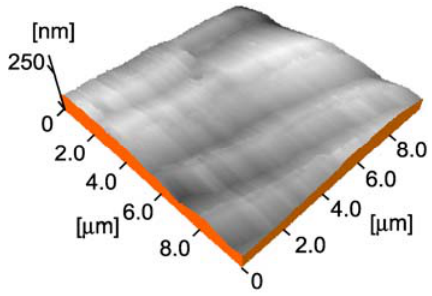
Figure 2. Typical AFM image of the (001) surface of AAB single crystal before photoirradiation.